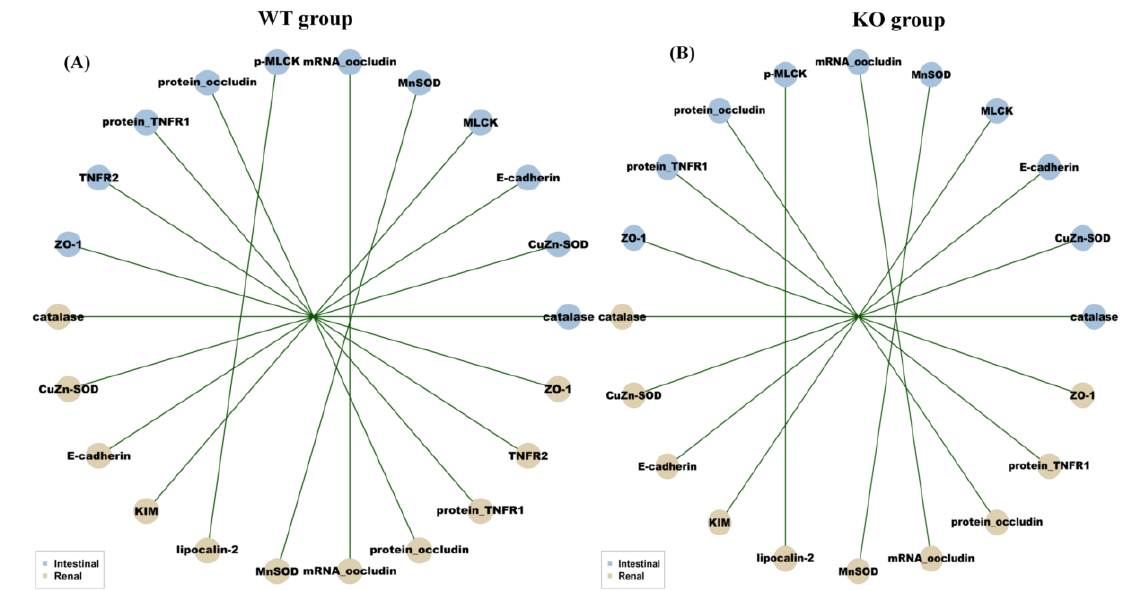
Figure 9. Crosstalk between intestinal/renal pathogenic markers and microbiota. Genetic deletion of intestinal SIRT1-related dysbiosis is associated with increased intestinal and renal pathogenic gene expressions. ( A , B ) Blue nodes: representative of intestinal or renal injury markers; brown nodes: differentially distributed bacteria genera in WT or KO groups. Green lines between nodes indicate positive relationships.